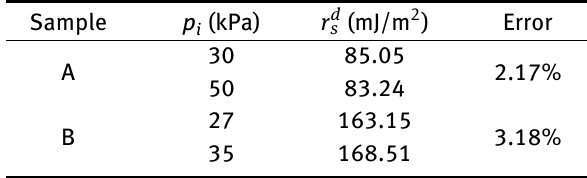
Table 1: r d s at different inlet pressures of column